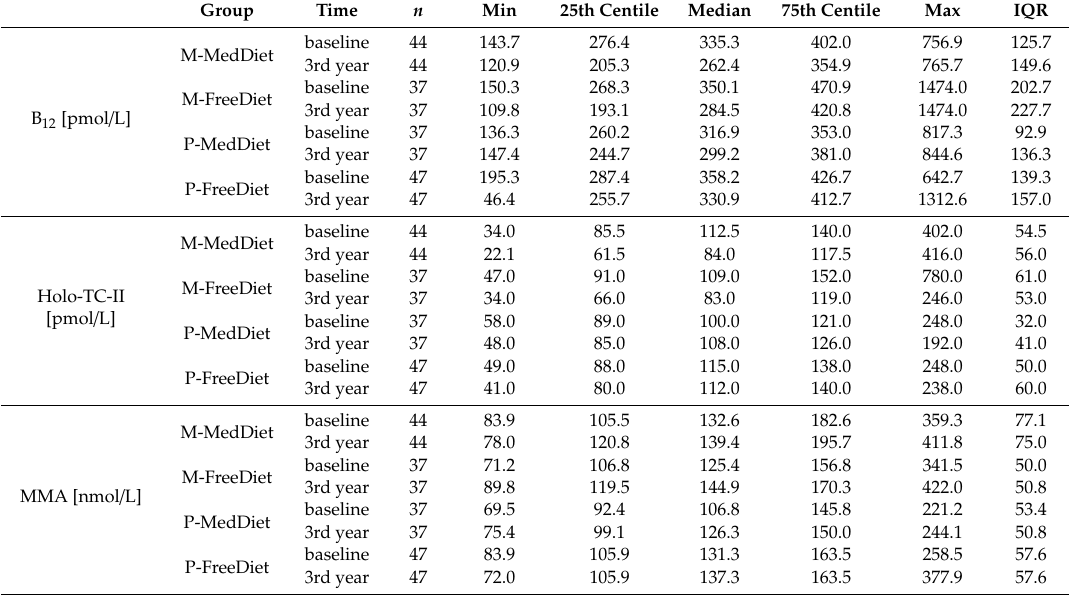
Table 1. Descriptive statistics of the variables